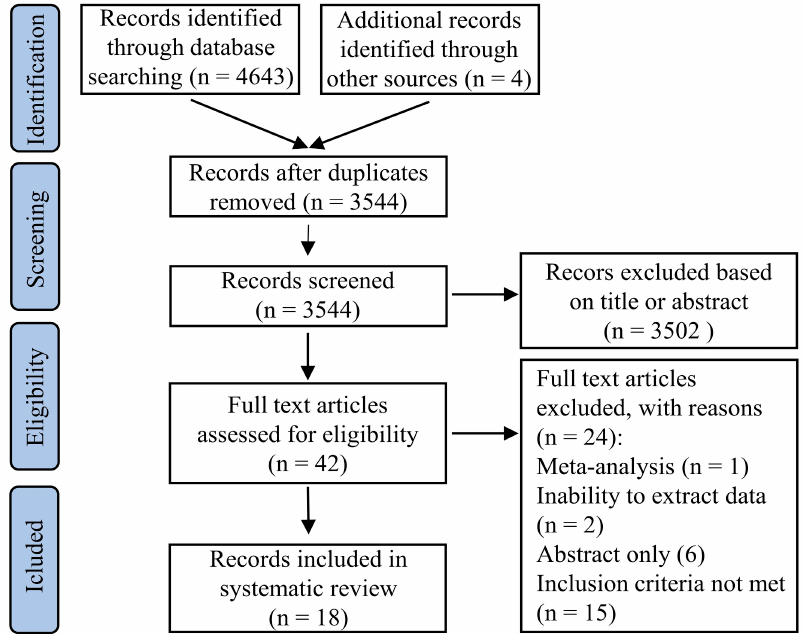
Figure 1. Flow diagram of the studies selection for inclusion in the systematic review.